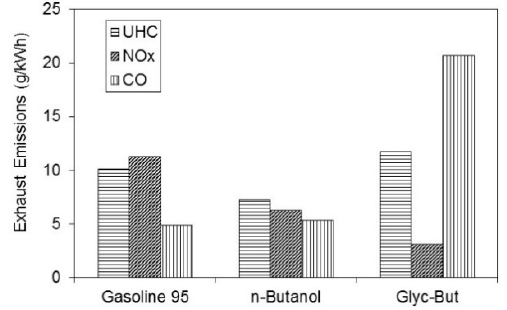
Figure 10. CO; NOx, and UHC specific emissions at optimal spark timings for gasoline, butanol, and Glyc_But fuels.